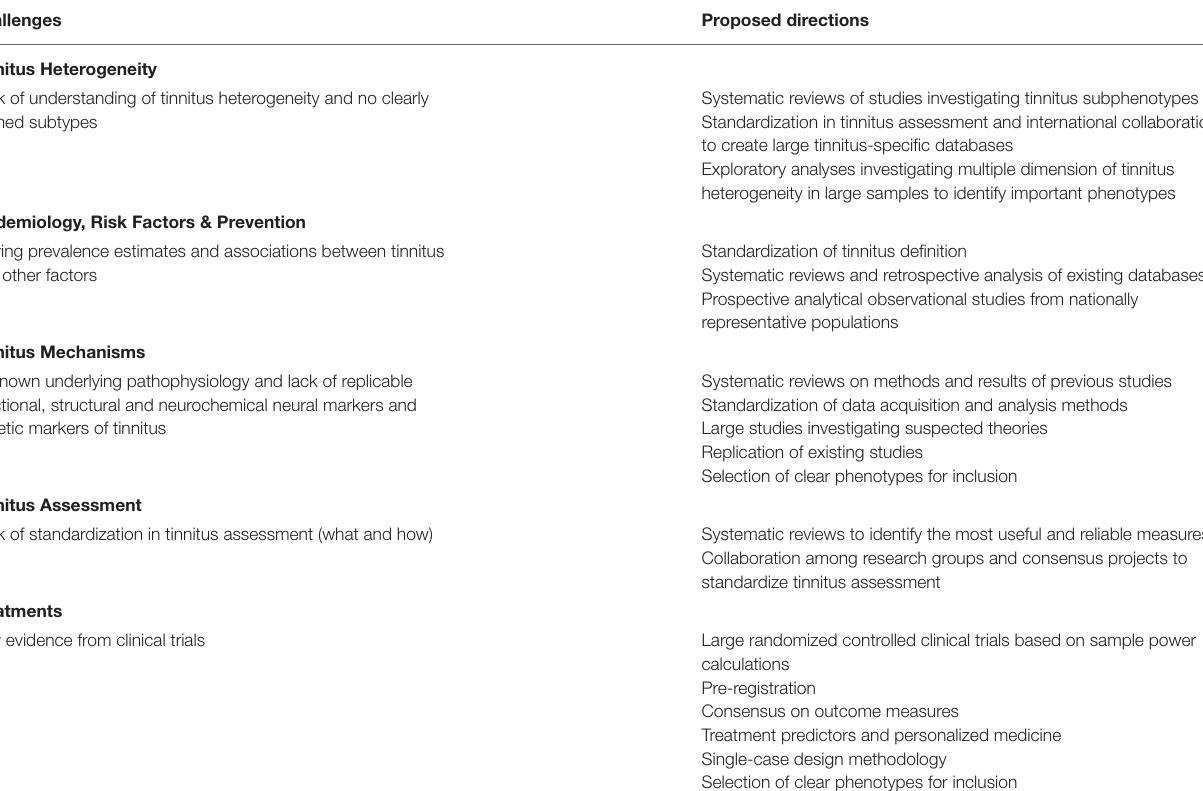
TABLE 2 | Overview of challenges in tinnitus research and proposed future direction towards a cure for tinnitus.